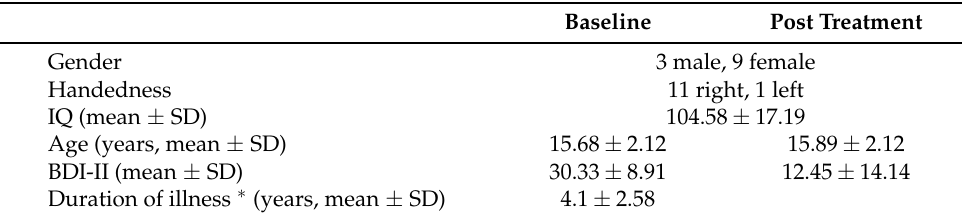
Table 1. Demographic